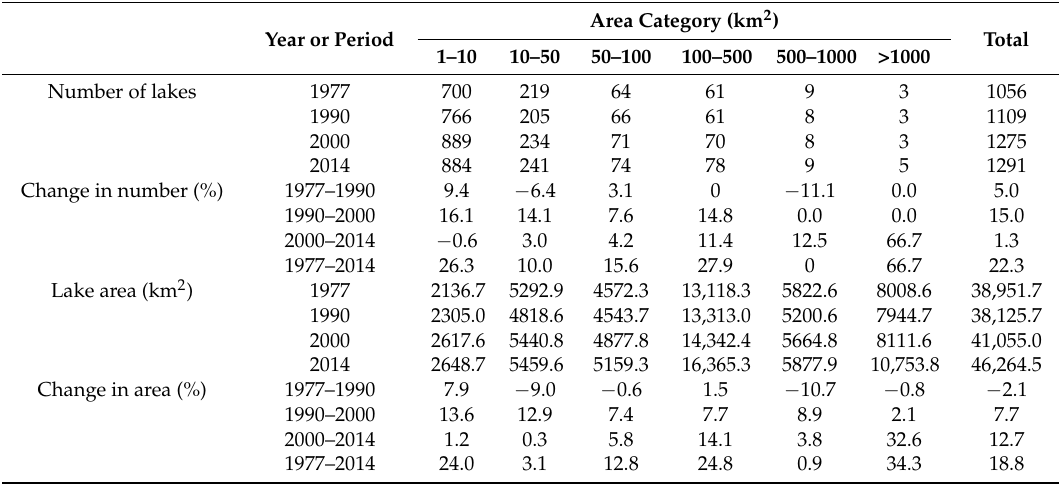
Table 2. Lake number, area, and its changes in different classes between 1977 and 2014.